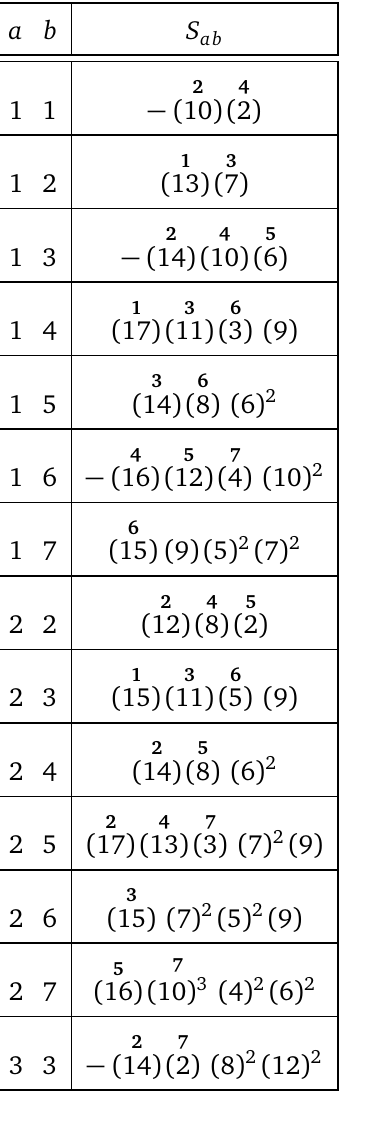
Table B.1: S -matrix amplitudes in the E